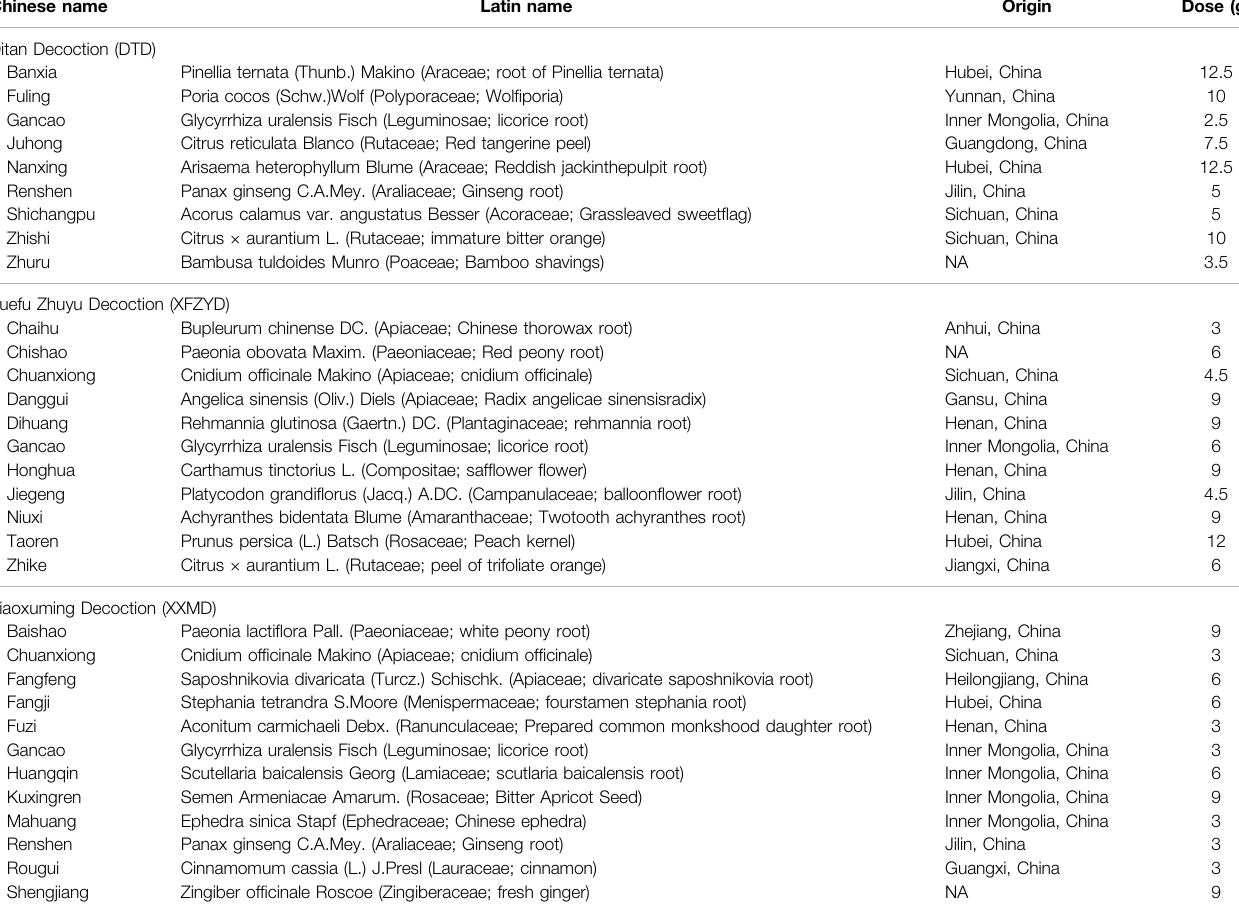
TABLE 1 | The name, origin, and dose of these botanical drugs in the three